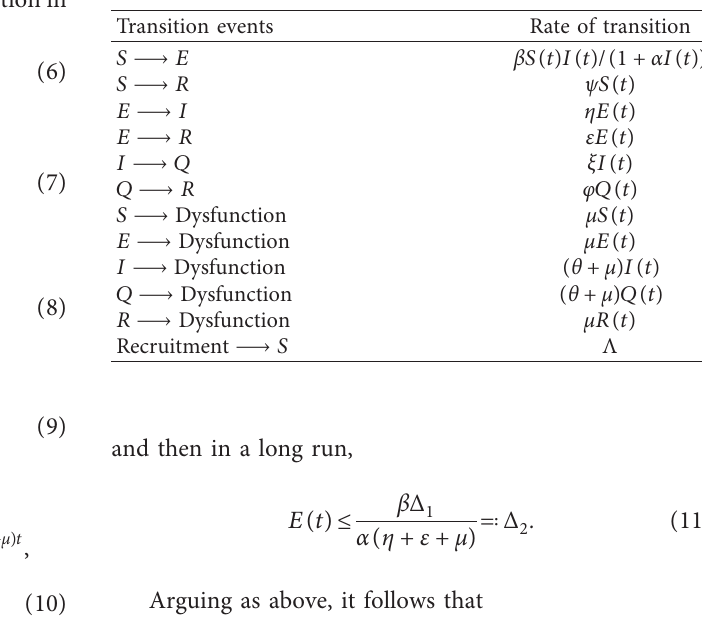
Table 2: State transition events and transition